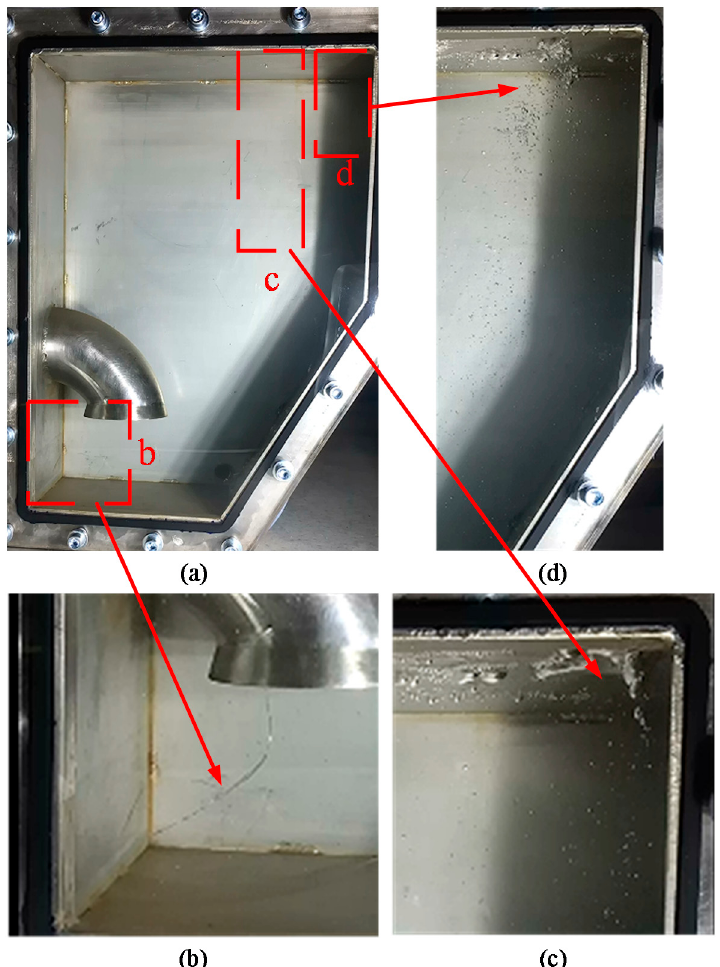
Figure 10. Vortices in the secondary pump intake. ( a ) Vortex location, ( b ) back wall attached-vortex, ( c ) vortex pulling serial air bubbles from top wall to the secondary pump intake, ( d ) vortex pulling air bubble group (screw) from top wall to the secondary pump intake.